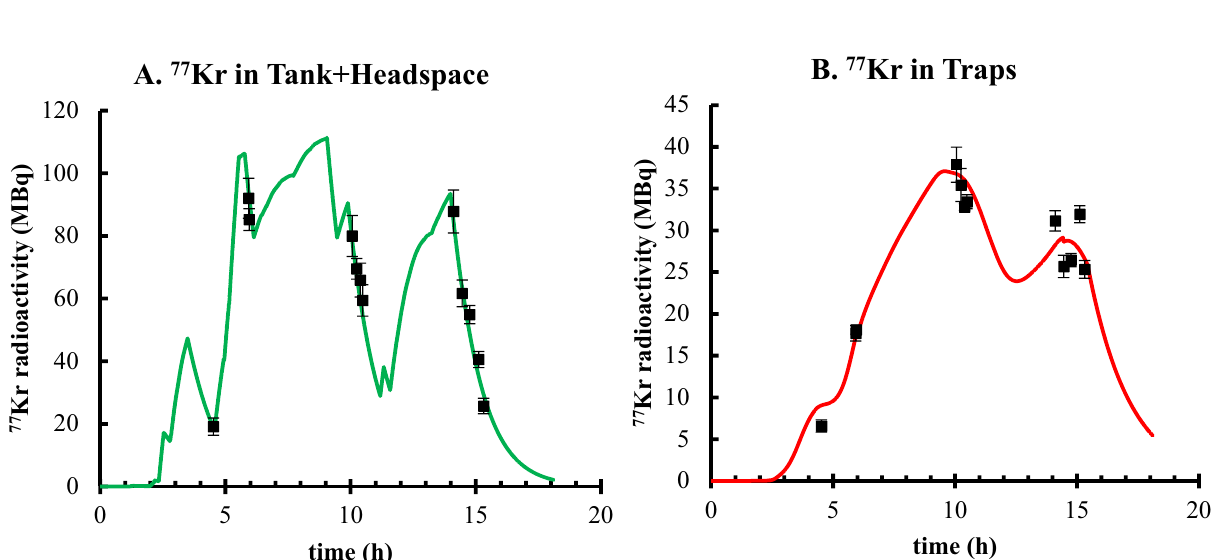
Figure 5. The mass transport of 77 Kr was predicted for different locations within the harvesting system – ( A ) the water and the headspace in the tank (green) and ( B ) the traps (red). Real time data of the 77 Kr activity calculated from the gamma spectra from the NPI detector are shown for comparison to the